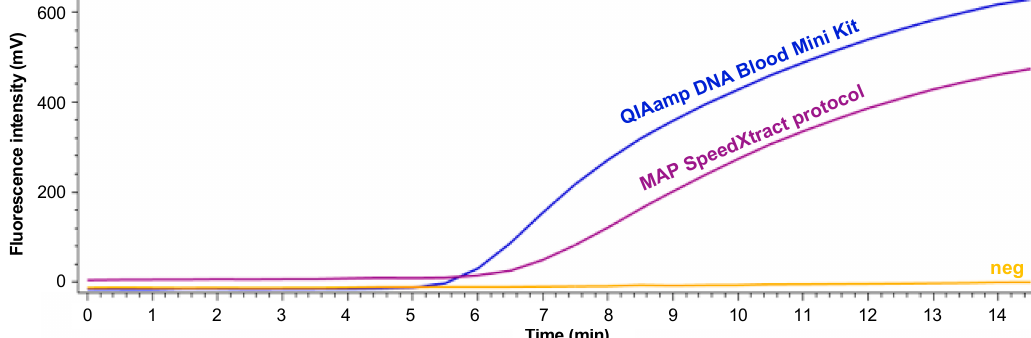
Figure 2. RPA results of DNA extracted either by using the QIAamp DNA Mini Blood Kit (blue) and the MAP SpeedXtract protocol (purple). Neg is negative.